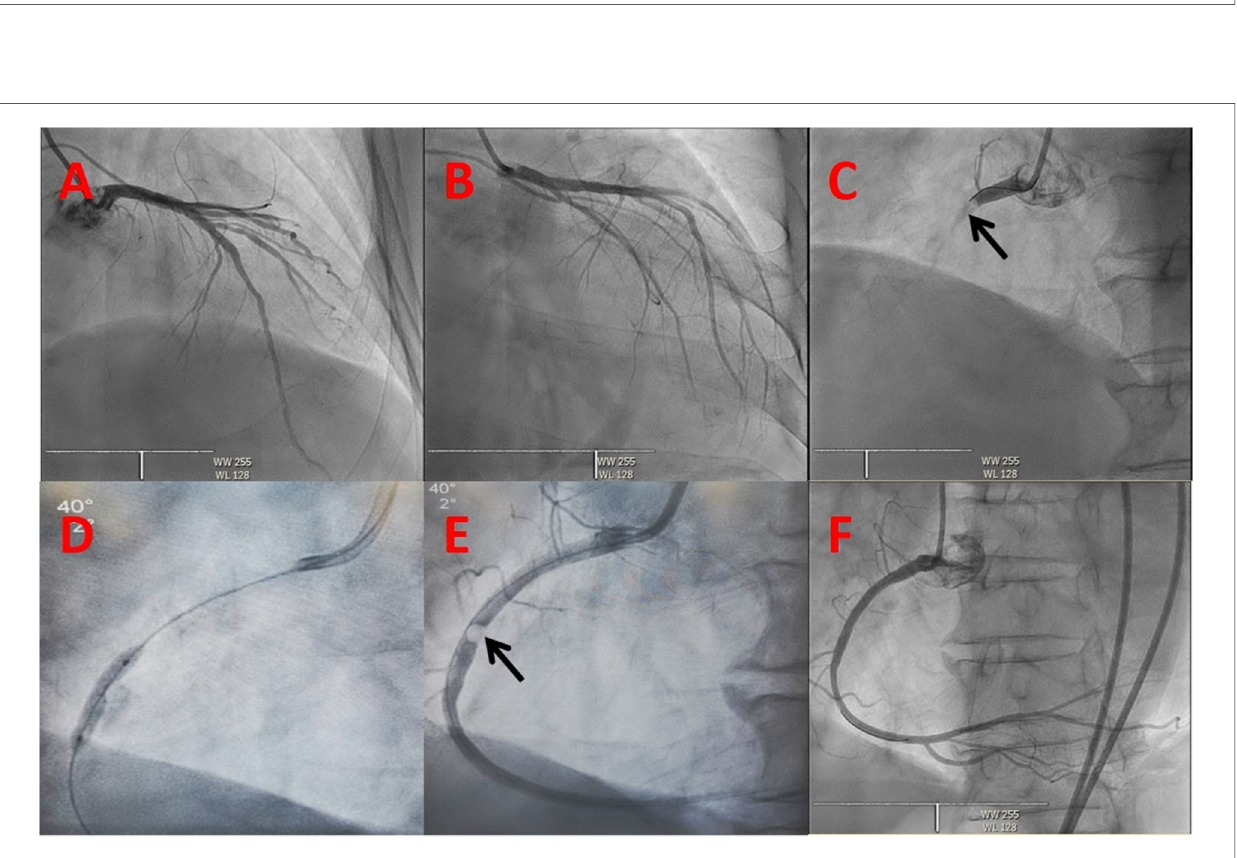
FIGURE 2 Coronary angiogram. The initial view of the coronary angiogram in ( A – C ) revealing a normal left coronary system and an embolism in the proximal right coronary artery (dark arrow): ( A ) Cranial 30, ( B ) RAO 30+Caudal 30, ( C ) LAO 40. ( D ) Hourglass sign of balloon angioplasty. ( E ) Embolus in the proximal right coronary artery (dark arrow). ( F ) Right coronary angiogram showing TIMI 3 blood fl ow after the